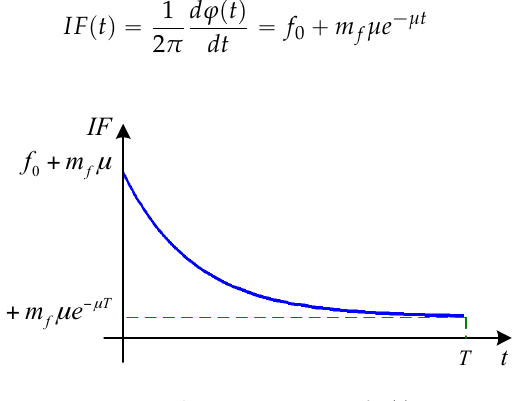
Figure 2. The TF signatures of ( ) x t .